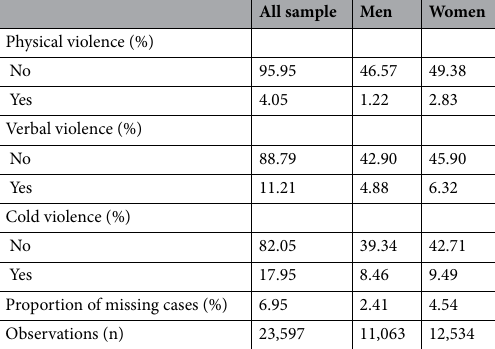
Table 1. Descriptive statistics of IPV and missing